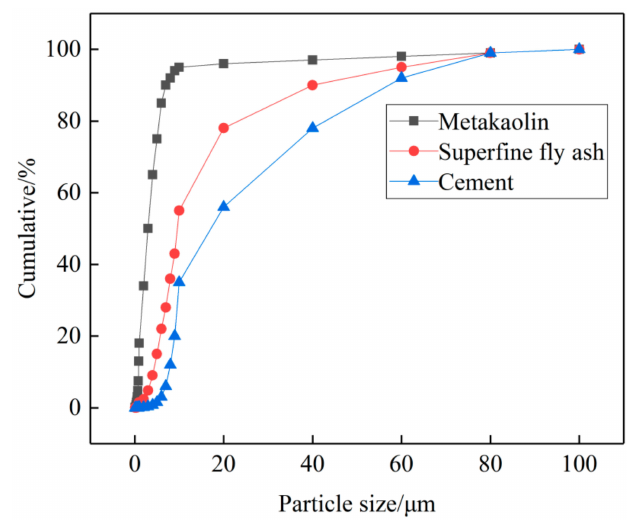
Figure 1. Particle size distribution of raw